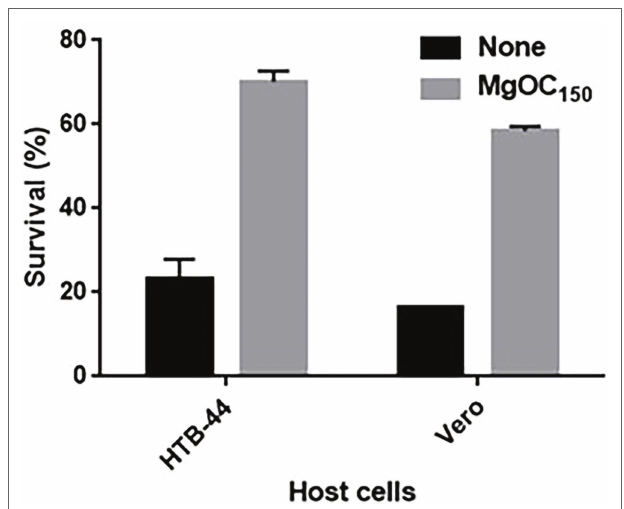
FIGURE 2 | Survival of HTB-44 and Vero cells after incubation with and without EHEC supernatant cultured with and without MgOC 150 . Survival rates are presented as the percentages of the RLU value for cells after incubation with each supernatant relative to that after incubation without supernatant. Data are the means of two biological replicates. Error bars indicate the ranges. Experiments were repeated twice, and similar results were